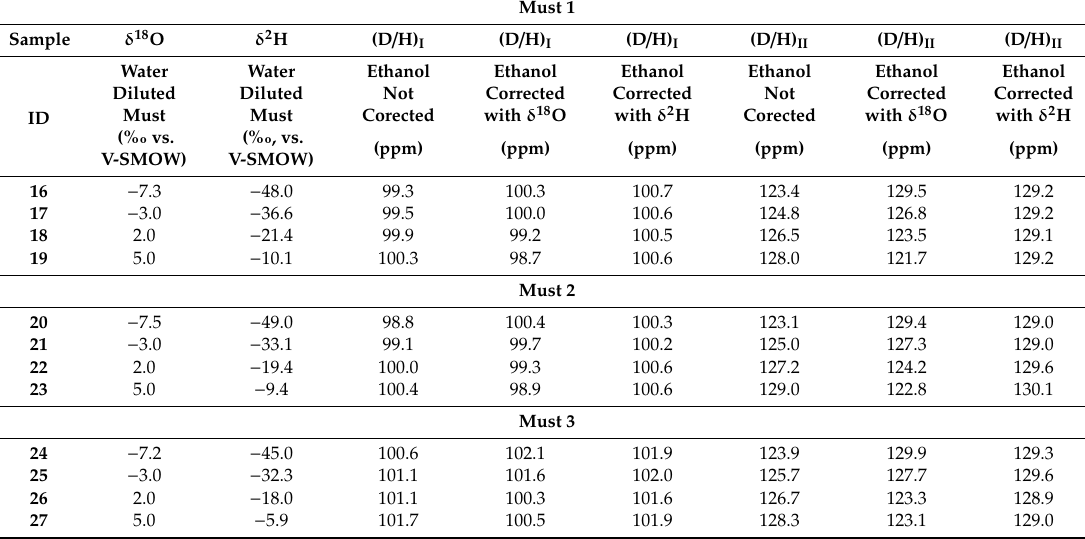
Table 2. δ 18 O and δ 2 H isotopic values of diluted sugar samples and of (D / H) I and (D / H) II of ethanol obtained after fermentation of the three di ff erent musts without correction and after correction using δ 18 O and δ 2